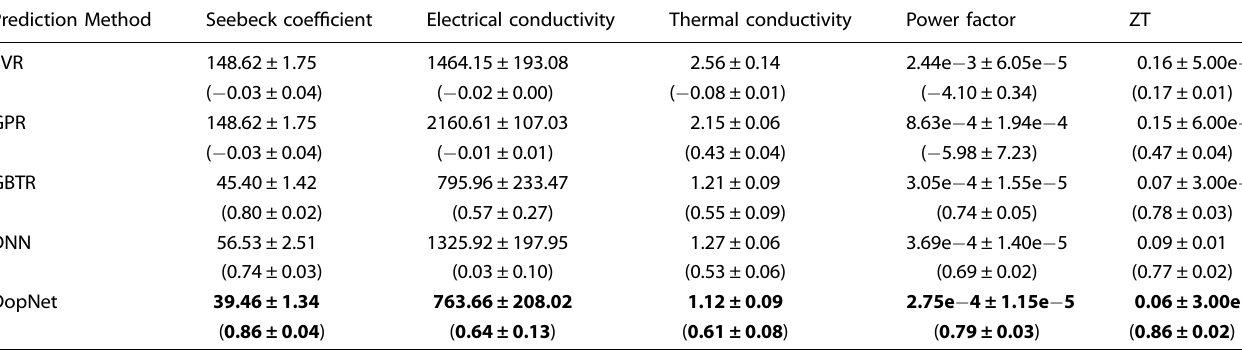
Table 1. Prediction errors of SVR, GPR, GBTR, DNN, and DopNet. Prediction Method